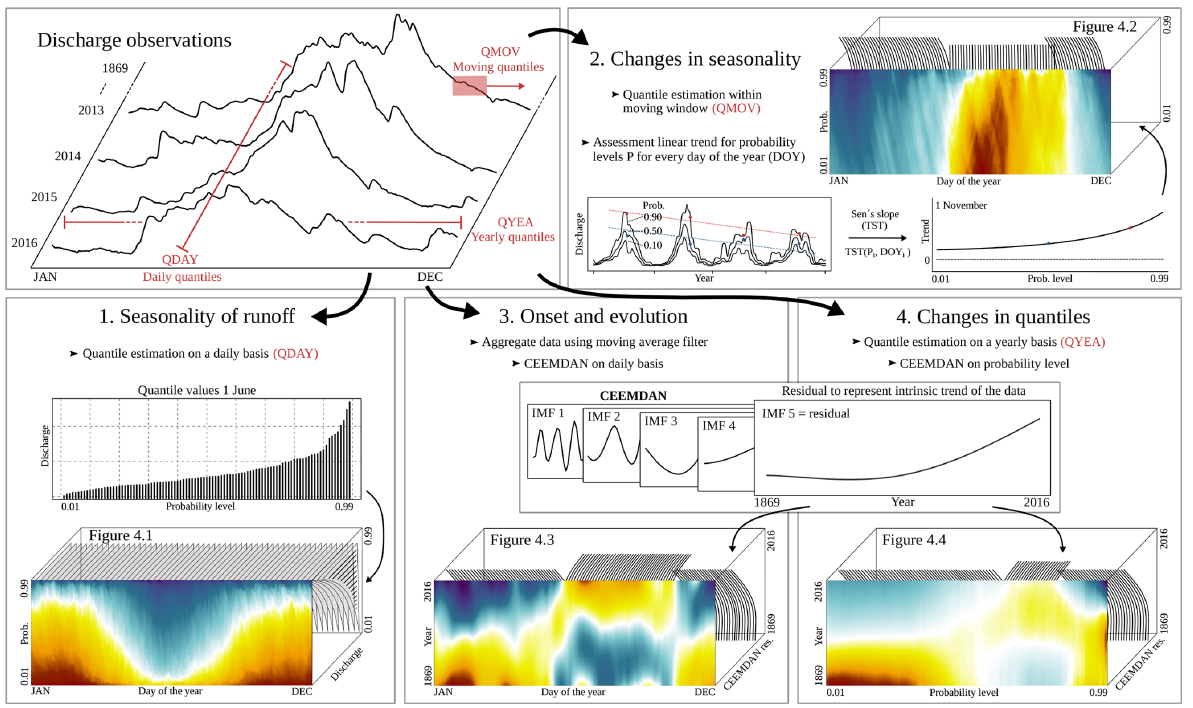
Figure 3. Schematic overview of analytical tools used to detect long-term changes in hydro-climatological time series. The analysis of discharge data is subdivided into four steps, where each step complements and extends the information acquired in the previous step.